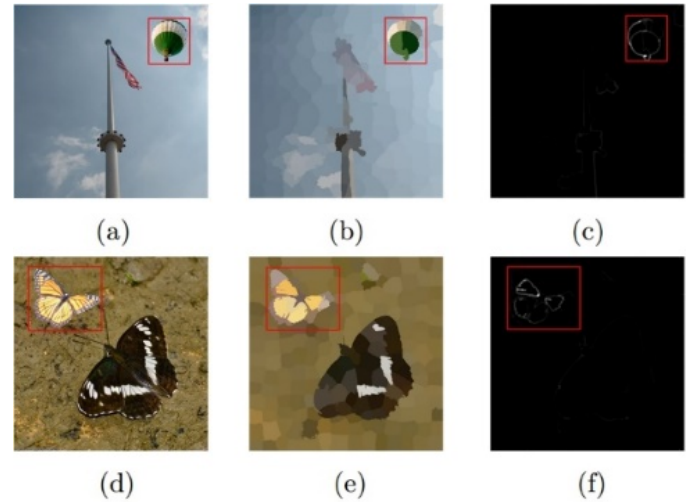
Figure 2. The results of the CCW chroma detection. ( a , d ) Tampered images; ( b , e ) the images after superpixel segmentation; ( c , f ) chroma detection results. The red box area denotes the tampered area hereinafter.